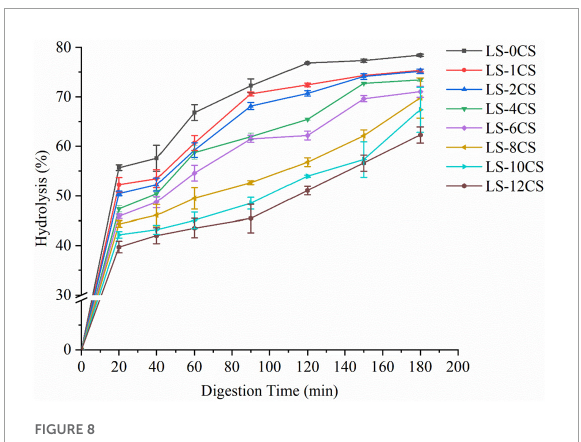
FIGURE8 Hydrolysis rates of lotus seed cross-linked resistant starch